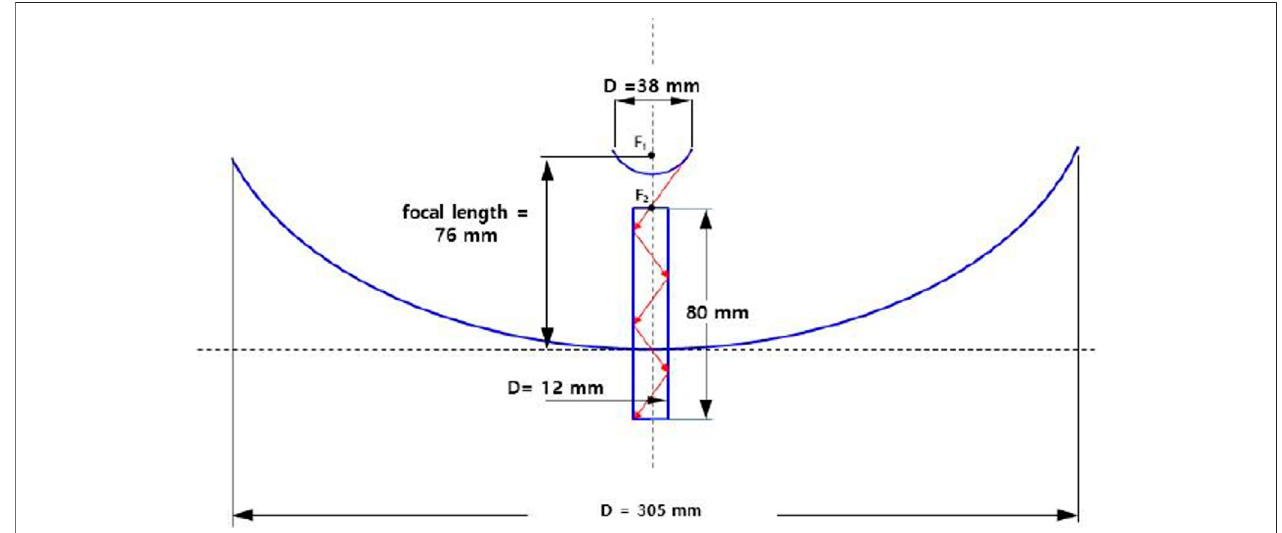
FIGURE 3 | Detailed geometries of the primary parabolic concentrator, the second hyperbolic re fl ector, and the homogenizer.